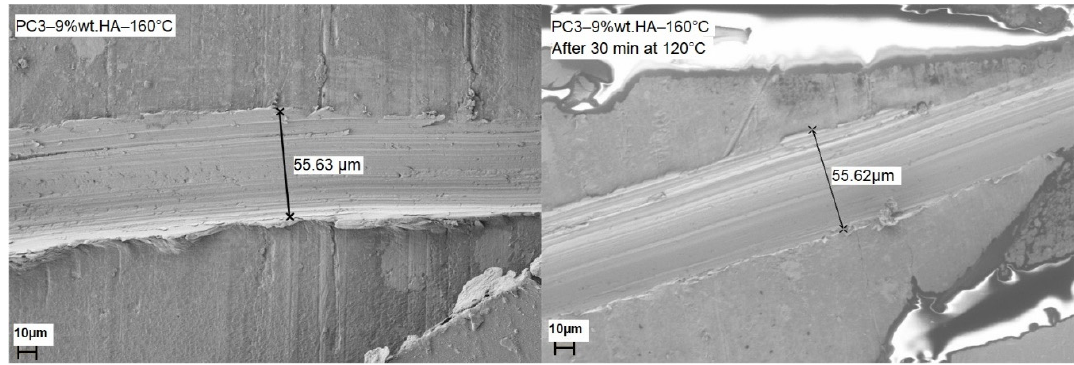
Figure 11. SEM images of PC3–9%–160 °C before and after healing of the scratch by heating sample to 120 °C for 30 min.